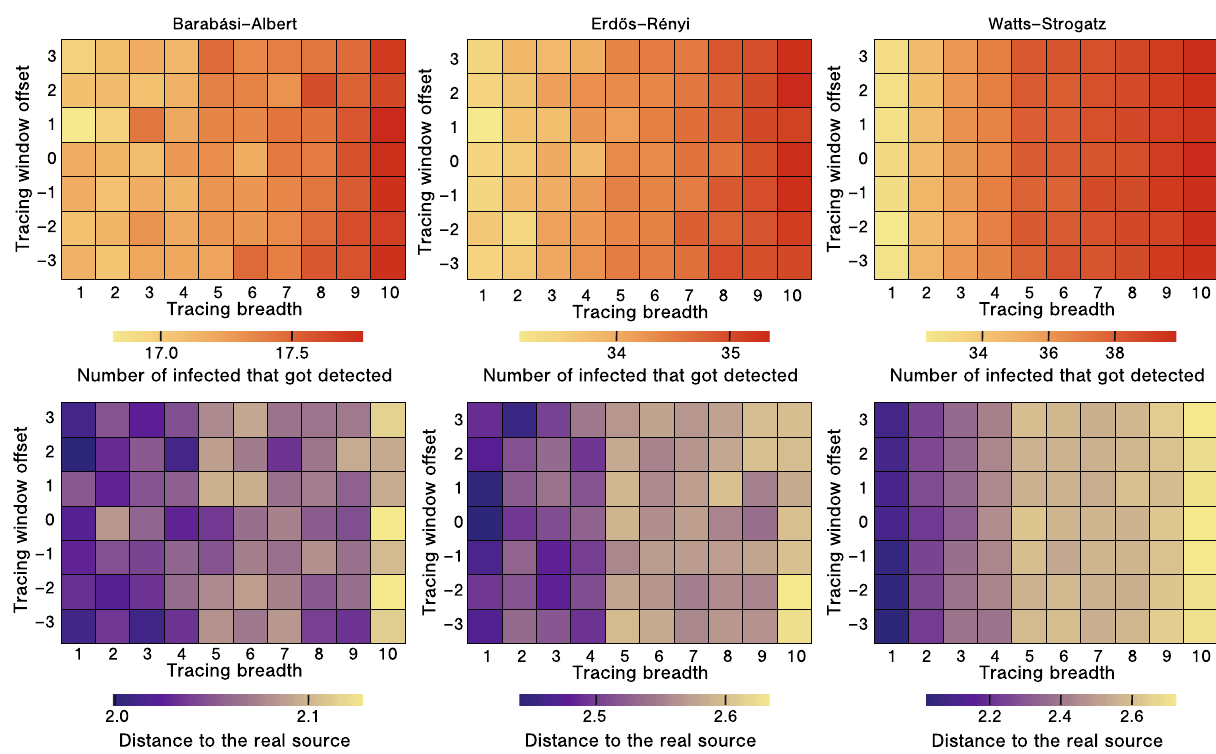
Figure 3. The effectiveness of tracing for varying β tr and ω tr . In each plot, the x-axis corresponds to the tracing breadth parameter β tr (with greater values indicating more focus on the breadth). The y-axis corresponds to the tracing window offset parameter ω tr (with greater values indicating the window shifted to the future). The plots in the first row present the number of infected detected by the tracing process, colours closer to red indicate more effective detection. The plots in the second row present the number of edges between the earliest detected infection and the actual source. The colour closer to blue indicates more effective detection. Each column shows results for networks with 10,000 nodes generated using different models, either Barabási–Albert, Erdős–Rényi, or Watts–Strogatz, with tracing budget b = 10 . The results are presented as an average of over 1000 simulations, with a new network generated for every